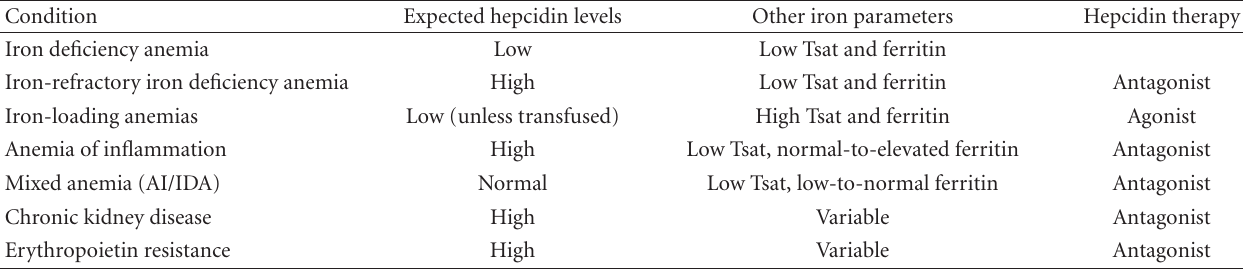
Table 1: Diagnostic and therapeutic potenital of hepcidin in di ff erent forms of